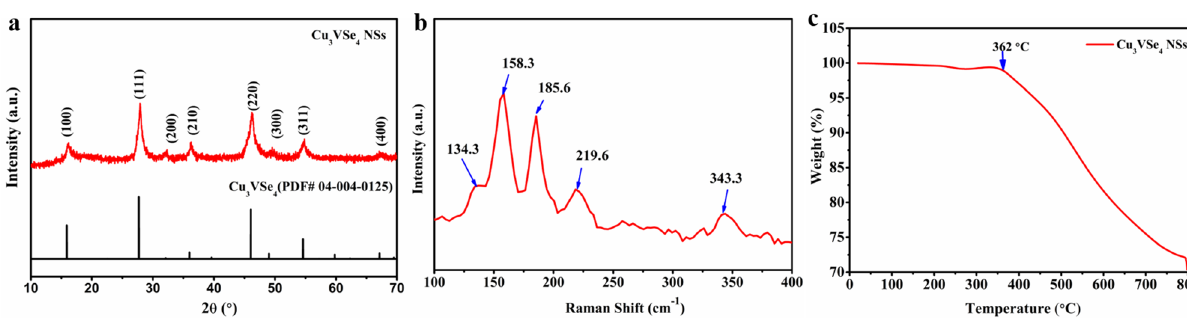
Figure 2. Characterization of Cu 3 VSe 4 NSs. ( a ) XRD pattern. ( b ) Raman spectrum. ( c ) TGA